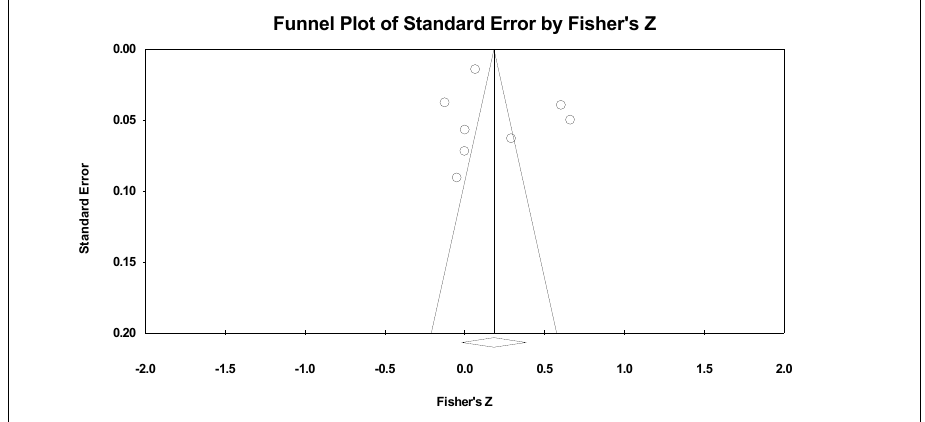
Figure A2. Funnel plot of ENV - AT.